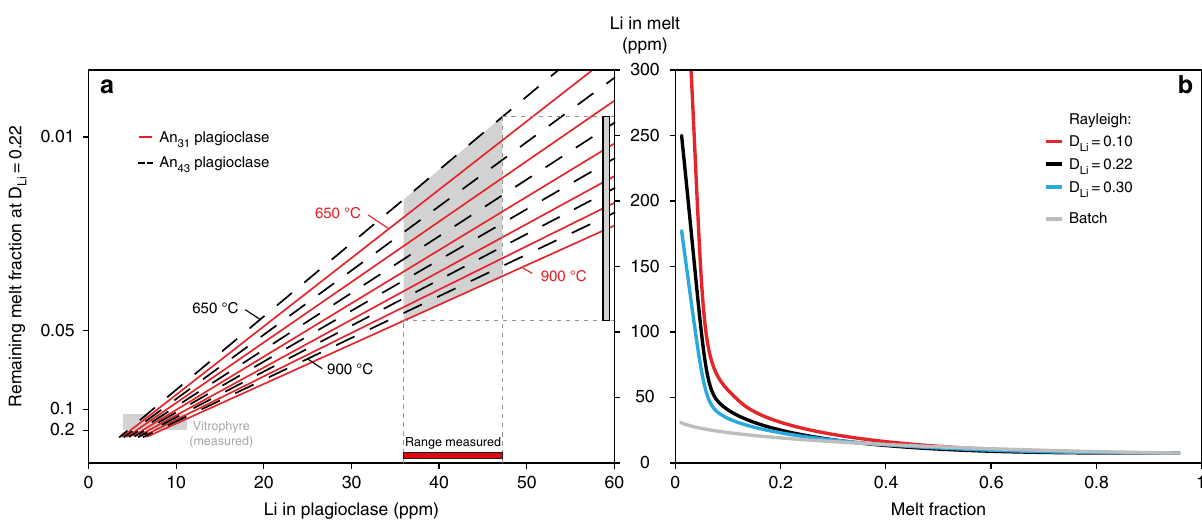
Fig. 5 Models of conditions necessary for Li enrichment in plagioclase within the slowly cooled portions of the Tuff of Knob. a Equilibrium relationship between plagioclase and melt Li contents using the partitioning model of Dohmen and Blundy 44 . Shown here are calculations with the most anorthitic (An 43 ) and average (An 31 ) plagioclase compositions with temperatures ranging from 900 °C to 650 °C at 50 °C intervals. These calculations assume a constant D Na of 2.52, based on the glassy Tuff of Knob sample. Data from ref. 47 indicate that even when groundmass crystallisation is almost to completion, the D Na does not differ signi fi cantly (2.73 for Elk Butte). b Batch and Rayleigh fractionation models to predict the evolution of lithium content in the remaining melt as groundmass crystallisation progresses. Illustrated are a range of bulk partition coef fi cients for Li, but regardless of the value chosen, to reach the elevated values shown in a requires a Rayleigh fractionation process